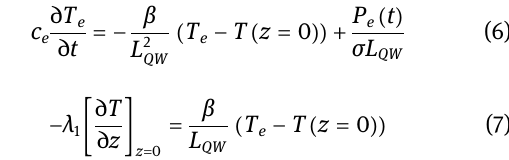
Figure 4: (a) Emitted power as a function of the modulation frequency (dots). The solid line is a result of modeling as described in the main text. The insets show two typical spectra for modulation frequency of 10 kHz and50MHz.(b)Schematicofsemiconductor layers from the quantum well down to the heat sink used for our thermal model. (c) Estimationsofthefrequency-modulatedpart of the excess electronic temperature Δ T e ( ω ) resulting from Eq. (9). The dashed line is the result of a simpli fi ed model where the effect of the semiconductor substrate has been